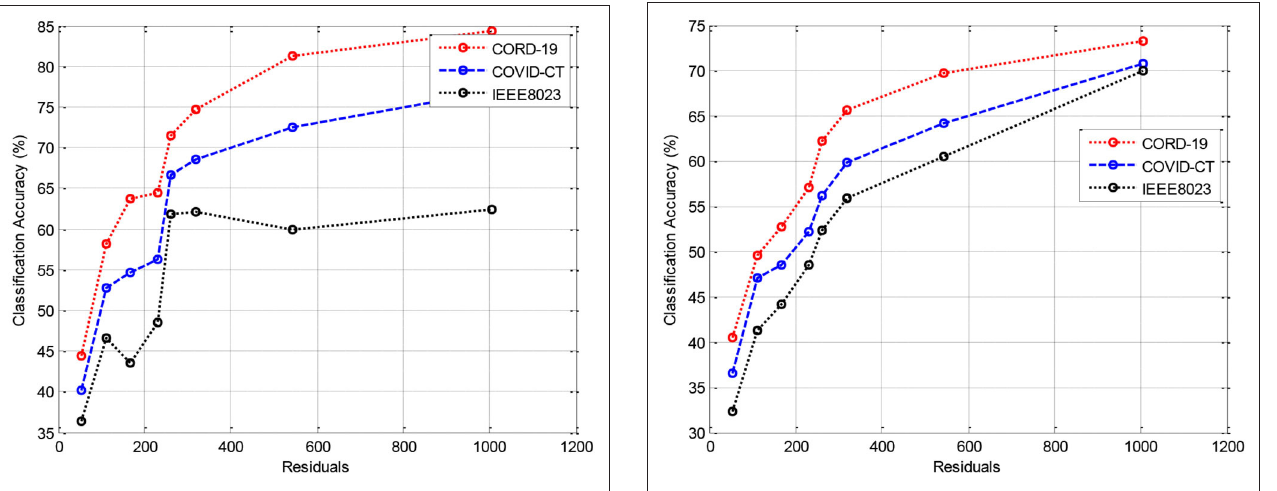
FIGURE 4 | Results of classification accuracy during training with 80% training data.